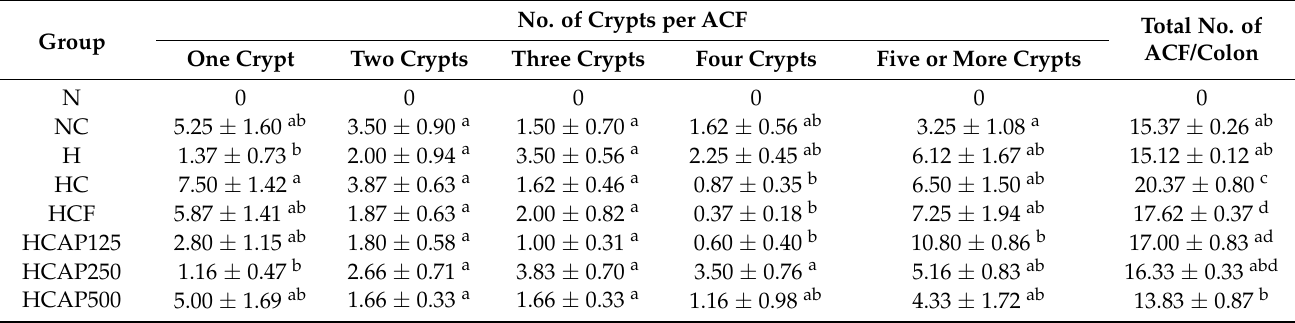
Table 3. Impact of A. paniculata on the overall number of ACF in the colon. No. of Crypts per ACF Total No. Group